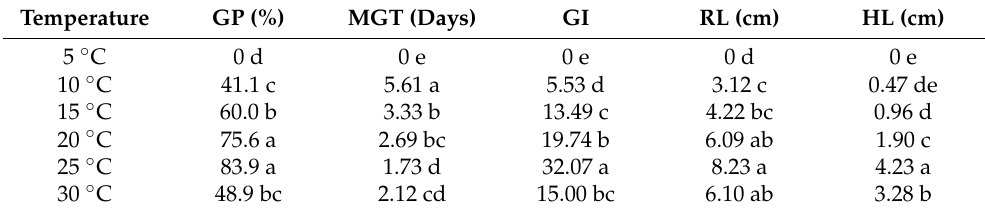
Table 2. Effects of temperature (5 ◦ C, 10 ◦ C, 15 ◦ C, 20 ◦ C, 25 ◦ C, and 30 ◦ C) on milk thistle seeds’ germination percentage (GP), mean germination time (MGT), germination index (GI), radicle length (RL), and hypocotyl length (HL). Seeds were stored for 5 months at room temperature (mean values of three